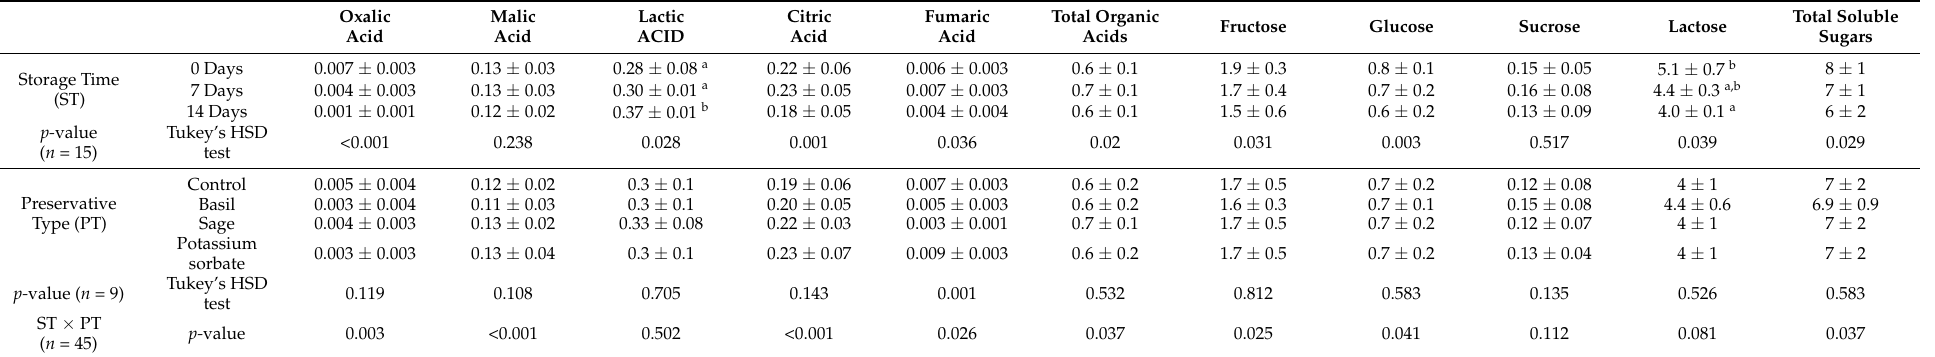
Table 5. Organic acids and soluble sugars profile of yogurts presented in g/100 g